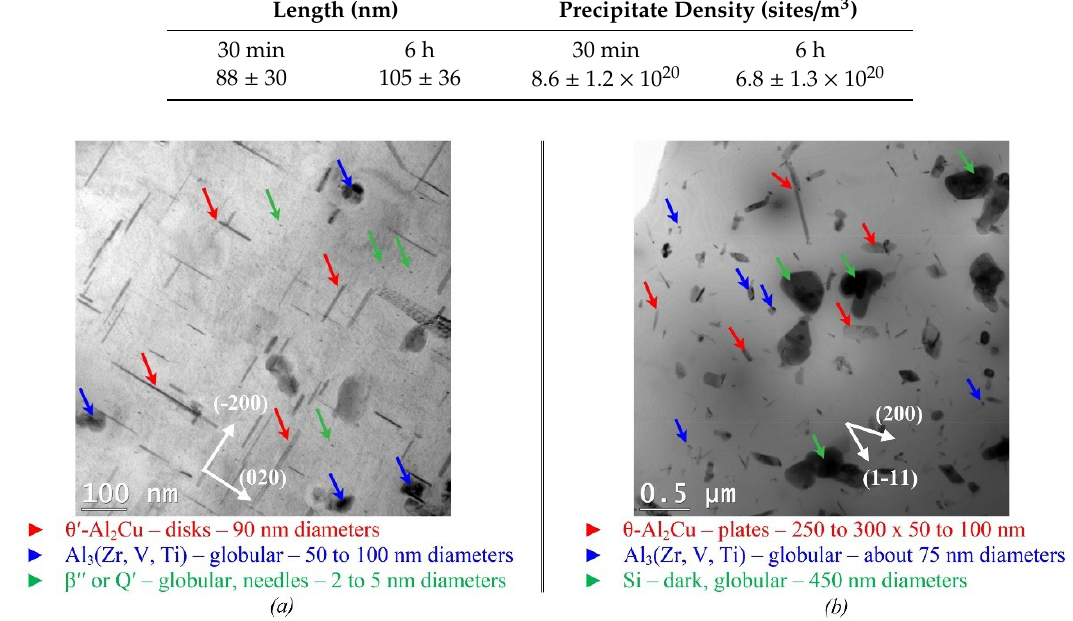
Figure 8. Detailed precipitate identification in the AlSi7Cu3.5Mg0.15 (Mn, Zr, V) alloy for aging ( a ) at 190 °C during 6 h; ( b ) at 350 °C during 12 h.